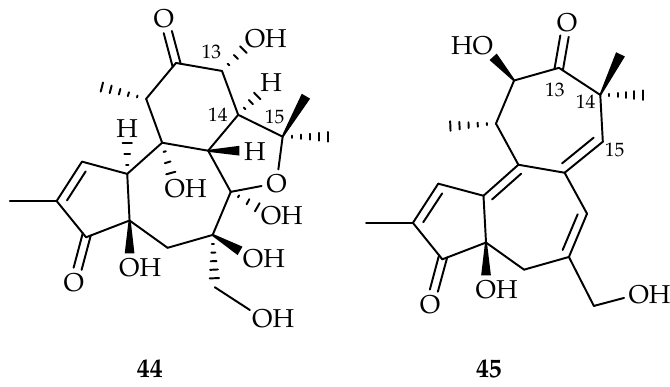
Figure 18. Structures of crotonol A 44 [29] and crotonol B 45 [29].